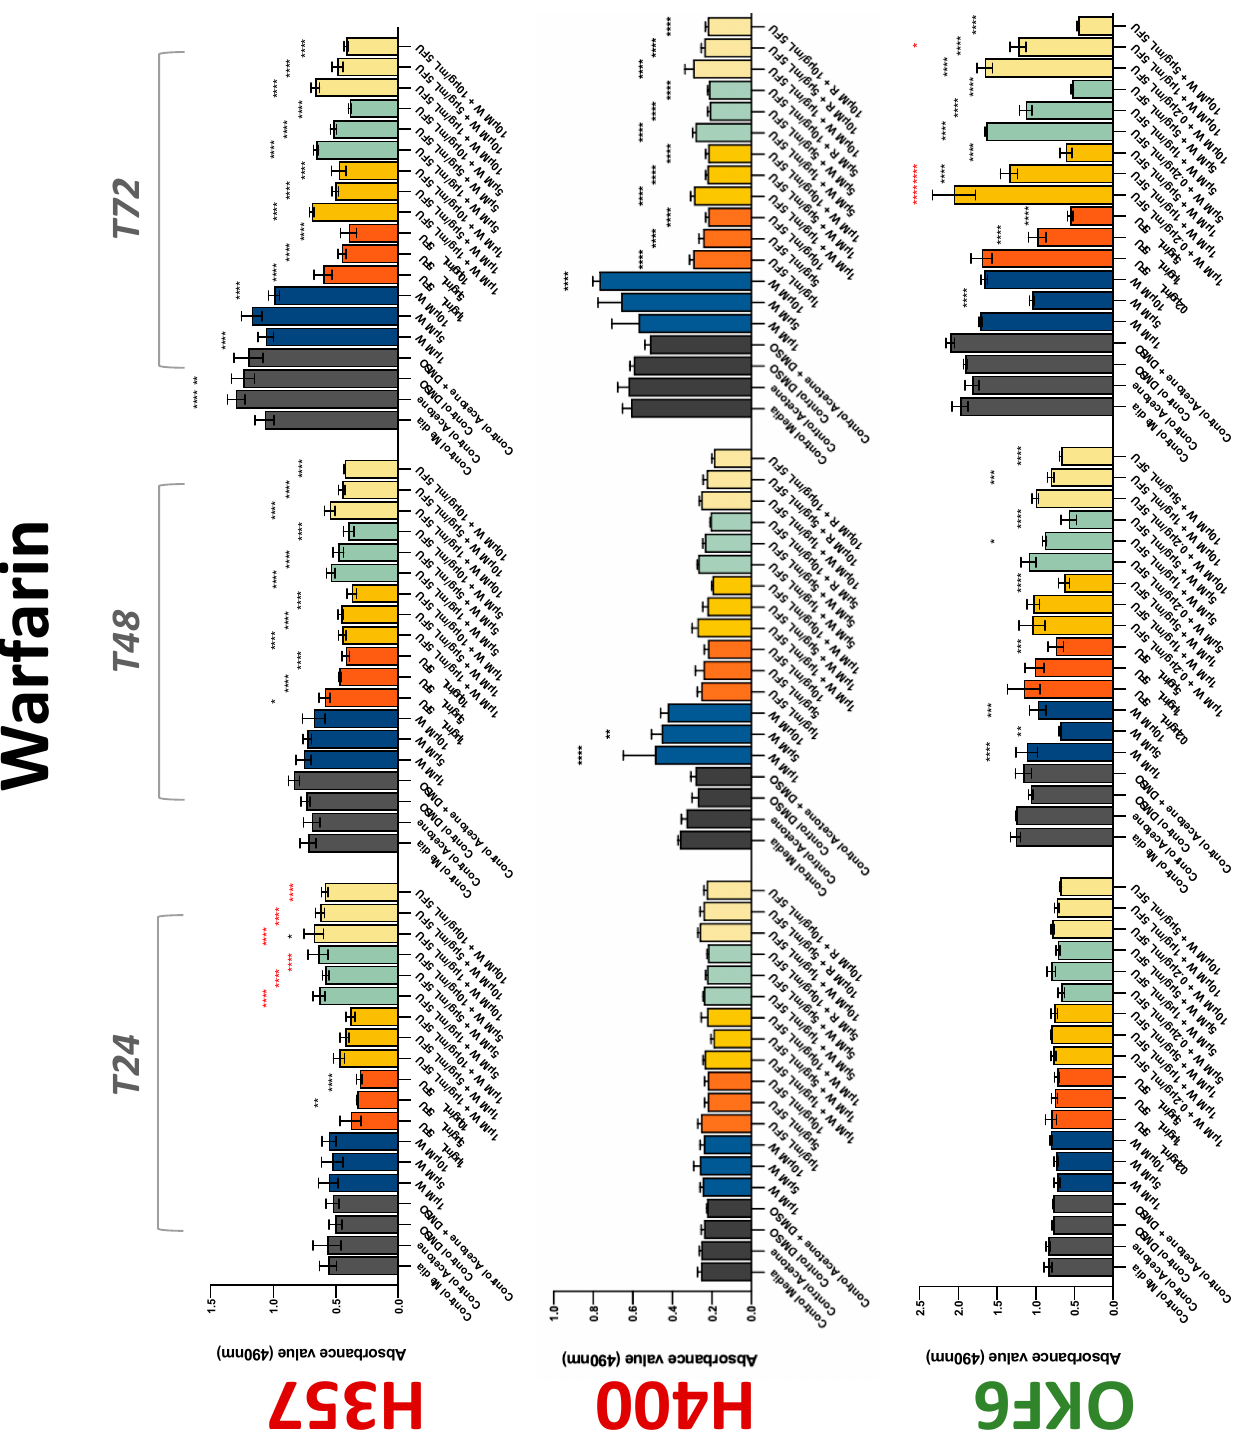
Figure 1. MTS assay . The effect of (1/5/10/20 μ M) warfarin and (0.2/1/5/10 μ g/mL) 5-FU on H357, H400, and OKF6 cell proliferation. Data are represented as mean ± SD. Statistical significance is given as follows: * p < 0.05, ** p < 0.01, *** p < 0.005, **** p < 0.001; * (black) compared to control group; * (red) compared to respective 5-FU